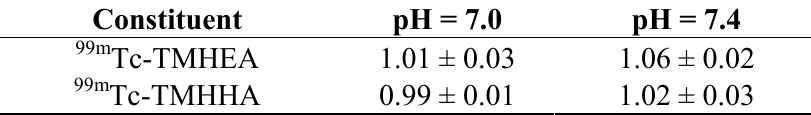
Table 1. Octanol-Water partition coefficient.